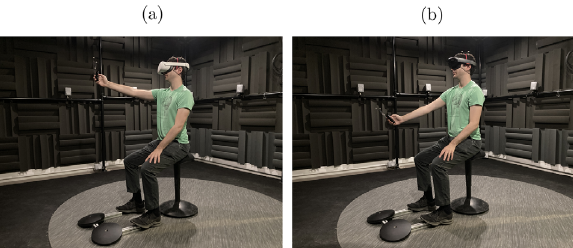
Figure 2. Experimental setup during the (a) Quest 2 and (b) Hololens 1